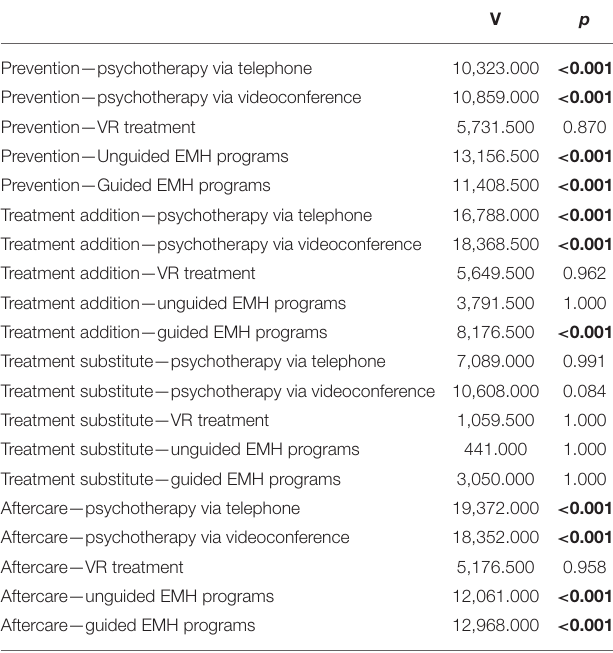
TABLE 2 | V-statistics of EMH service acceptance for different application